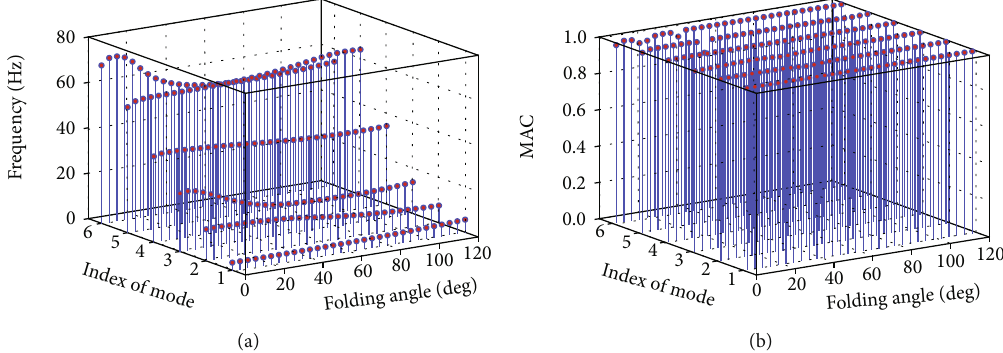
Figure 5: The matched structural modes (a) and the MAC between every two adjacent folding angles (b).